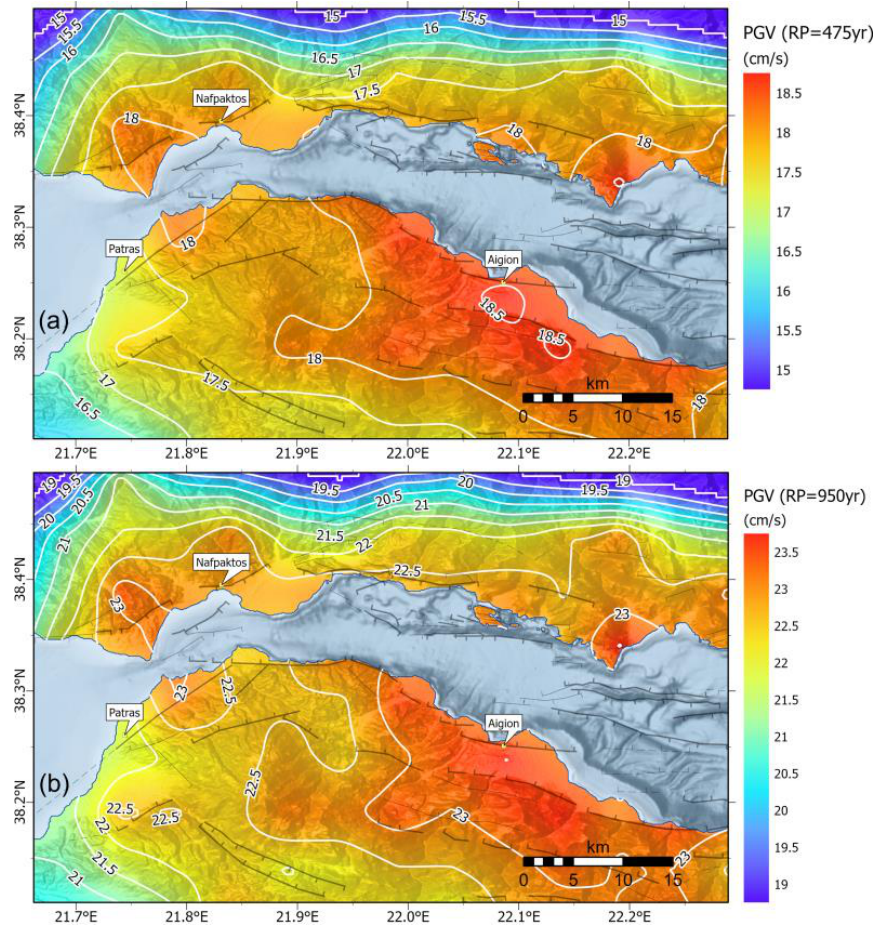
Figure 4. Spatial distribution of PGV values for ( a ) RP = 475 yr and ( b ) RP = 950 yr. Hazard curves were also generated for the three main WGoC city and towns; namely, Patras, Nafpaktos, and Aigion (Figure 5a). PGA values were calculated for a range of exceedance probabilities in 50 years to observe the increase rate for the PGA as a function of the return period. The hazard curves were proximal to each other, indicating that the level of seismic hazard was similar among the three sites. Patras presented a slightly lower PGA than Nafpaktos and Aigion. It could not be determined whether Aigion or Nafpaktos exhibited higher seismic hazard, as the PGAs were almost identical between the two cities. It is worth noting that the value of 1000 cm/s 2 was exceeded only for very small probabilities of exceedance, which implies that such extreme ground motions are unlikely to be reached. The last output of the PSHA calculations was the computation of Spectral acceleration (S a ) values for periods ranging from 0.1 s to 2.0 s in the three aforementioned sites in order to construct uniform hazard spectra (Figure 5b). The S a curves for Patras, Nafpaktos, and Aigion were very similar to each other throughout all periods. This was reasonable in light of the close geographical distance among them. As illustrated in both PGA and PGV maps, the city and the two towns were adjacent to regions of comparable maximum expected ground motions. The maximum of the three spectra was about 500 cm/s 2 at a period of 0.25 s. The curves seemed to be nearly identical for periods above 0.9 s. Thus, at high periods, there was almost no difference between the three sites.